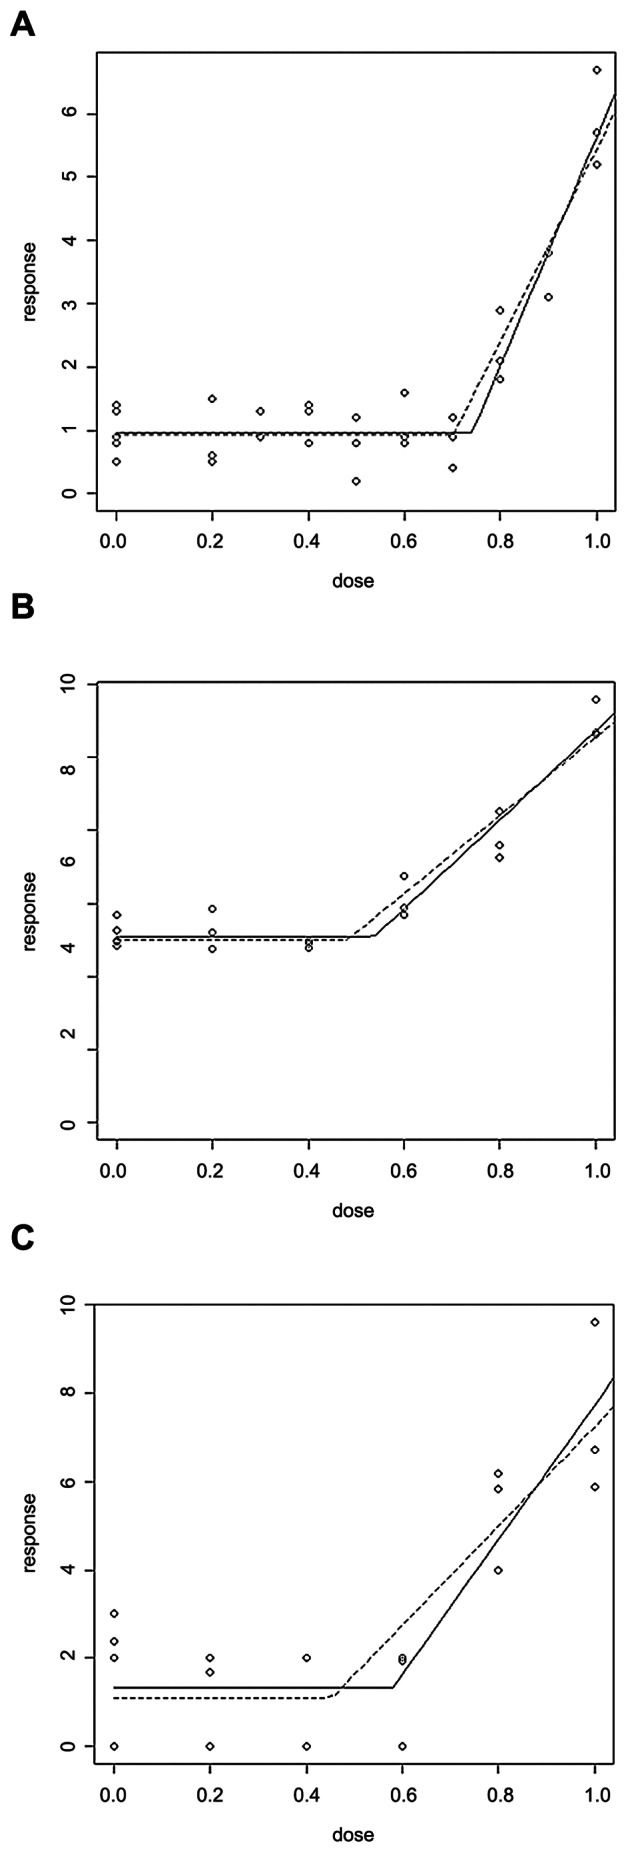
Mammalian cells treated with 17-β-oestradiol (E2) treated mammalian cells with the following endpoints.(a) MN (AHH-1), (b) MI (V79) and (c) Tripolar (V79). Graphs shown are from the Lutz and Lutz (2009, [23]) hockey stick model for R, with the dotted line being the lower 95% confidence interval. The x-axis ‘dose’ is in µM, and y-axis ‘response’ is % cells.